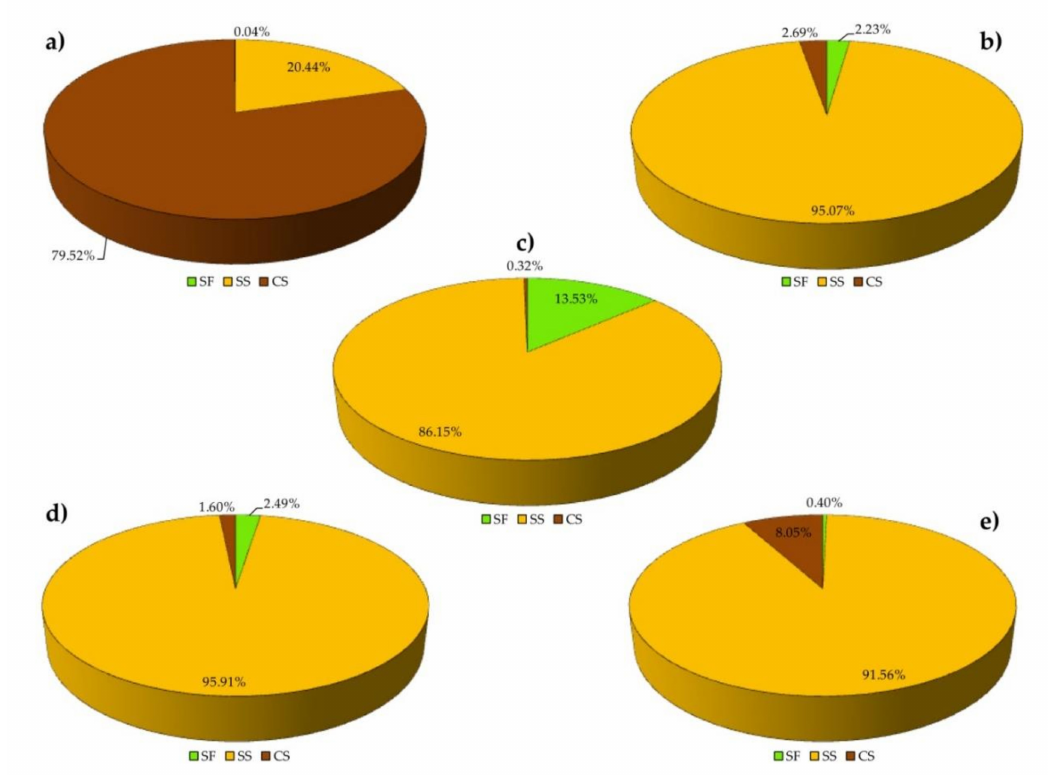
Figure 5. Harvesting scenarios percentage in each suitable sub-area. ( a ) A sub-area; ( b ) B sub-area; ( c ) C sub-area; ( d ) D sub Area; ( e ) E sub-area.